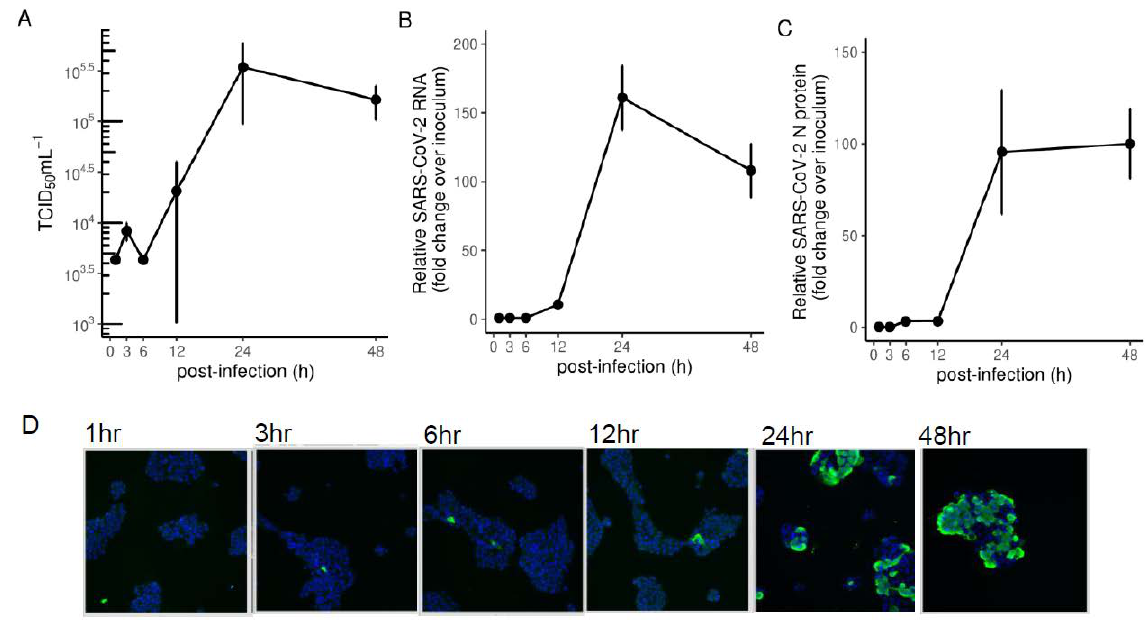
Figure 1. SARS-CoV-2 infection of Calu-3 cells ( A ) TCID50 measurements of virus titres, ( B ) qRT-PCR measurements of intracellular viral RNA represented by 2- ∆∆ Ct normalised first to GAPDH and then to inoculum levels of SARS-CoV-2, set to 1, and ( C ) intracellular viral protein in Calu-3 cells infected with SARS-CoV-2 (MOI 0.1). ( D ) Immunofluorescence microscopy showing SARS-CoV-2 N protein staining (green) in Calu-3 cells infected with SARS-CoV-2 (MOI 0.1) at various timepoints. Cell nuclei were stained using DAPI